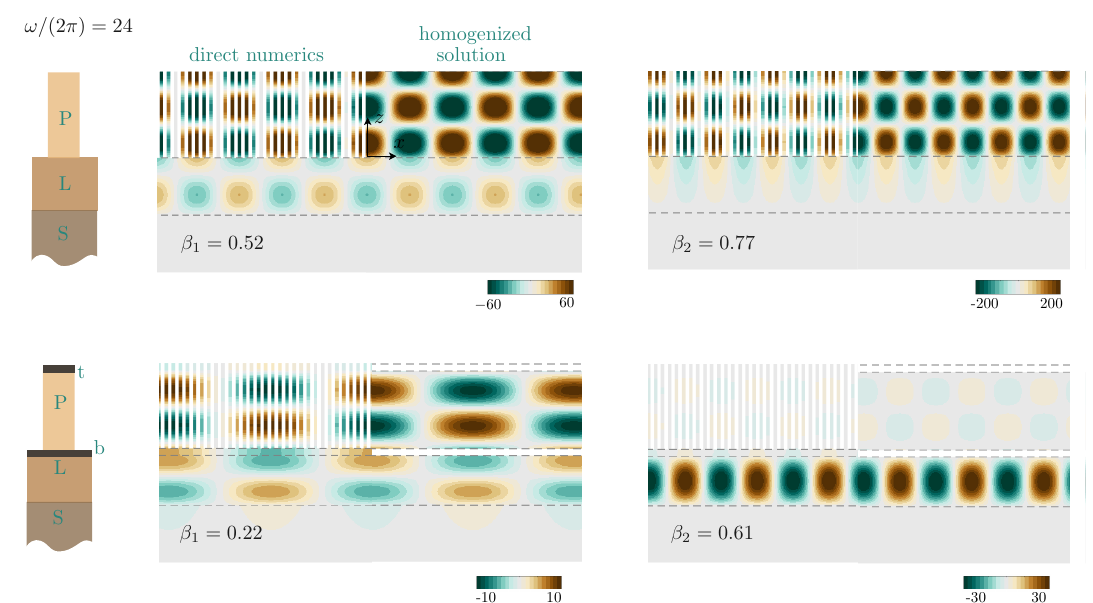
Figure 9. Displacement fields corresponding to the two branches of guided waves ( β 1 and β 2 ) at ω / ( 2 π ) = 24 for the undecorated plates (top) and decorated plates (bottom). On each panel, the field from direct numerics is plotted for x < 0, and the homogenized solution from (19) is plotted for x > 0. H In both cases, the displacement at z = is unitary, which allows for a quantitative comparison L − without any tuning